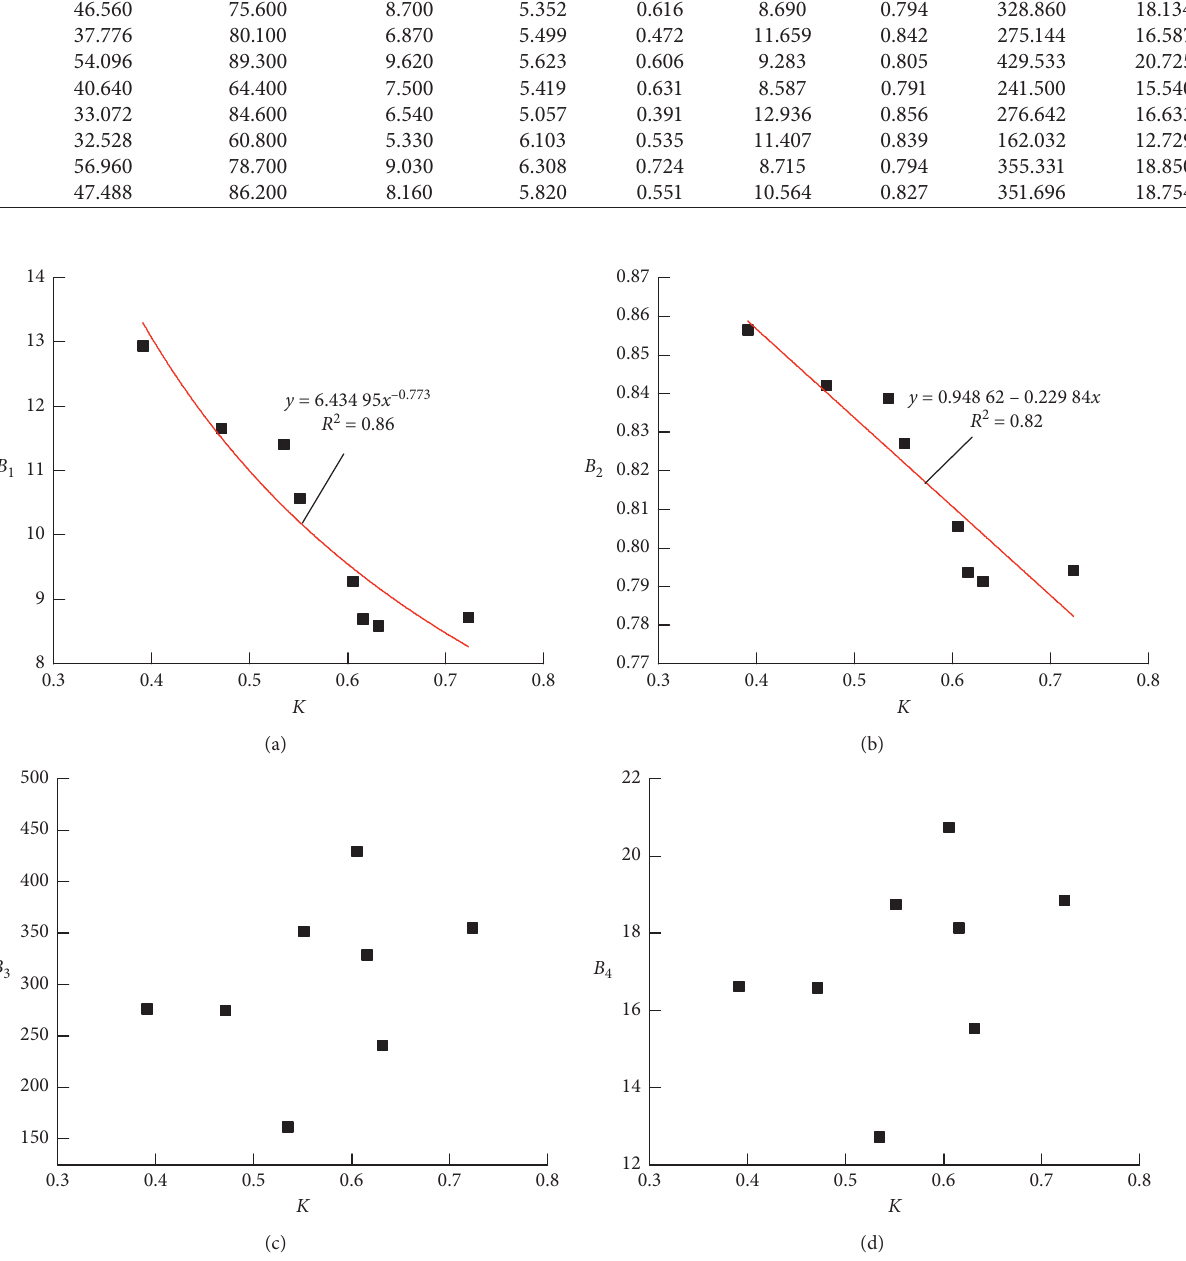
1 ; (b) B 2 ; (c) B 3 ; (d) B 4